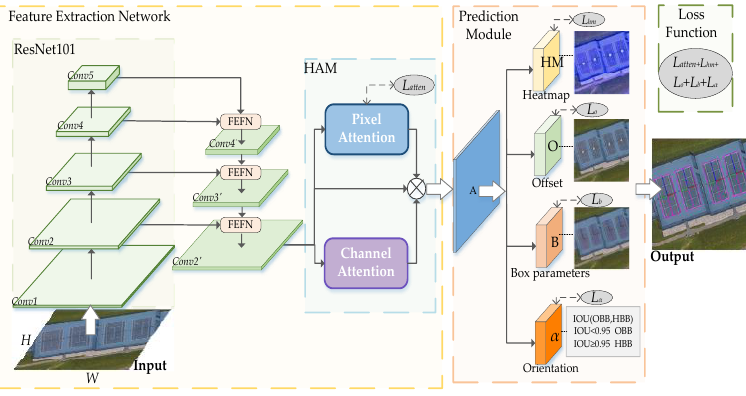
Figure 2. Overall framework of the proposed FEHA-OD. The input RGB image is I ∈ R 3 × W × H . After the feature extraction network, the feature map A is output as